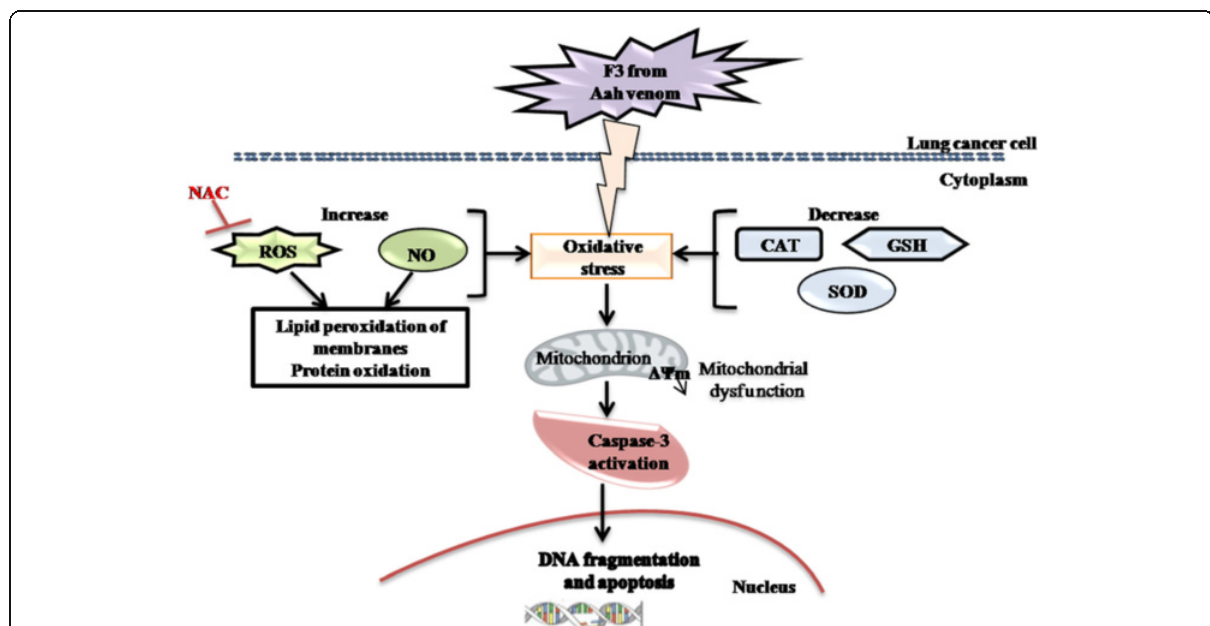
Fig. 10 Schematic diagram showing the mechanism by which toxic F3 fraction of Androctonus australis hector venom could induce apoptosis in non-small cell lung cancer